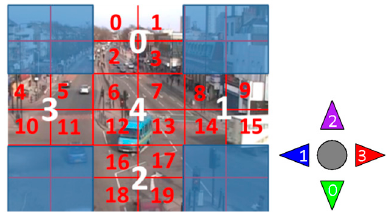
Figure 3. Directions and regions of simulation video